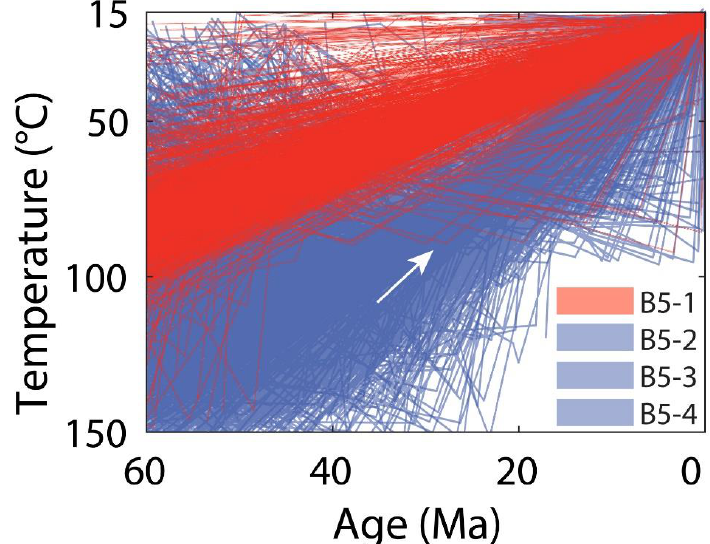
Figure 3. Thermal model results for individual single grain runs from sample B5 of [12]. Red represents results for date rejected by [12]. Blue represents dates not rejected by [12]. Results are shown as accepted individual time-temperature paths from post “burn in” model iterations. The white arrow points to accepted red paths that overlap with the blue histories.